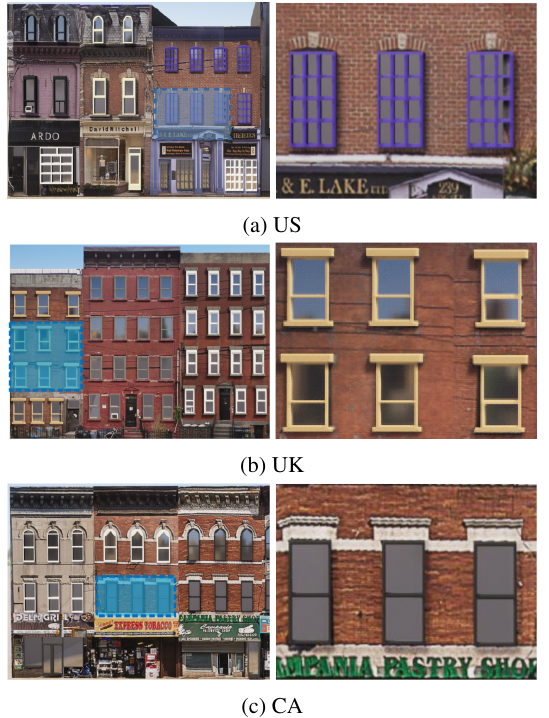
Figure 4. Reconstructed fac¸ades for the three datasets, in which the right column demonstrates the enlarged areas in the cyan rectangles.